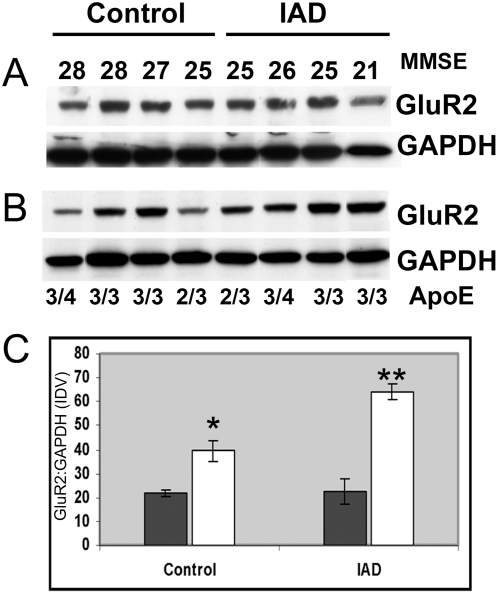
GluR2 protein expression.To determine if increased GluR2 mRNA generates elevated protein expression, we compared subjects with a range of MMSE values. Representative immunoblots of A) homogenates and B) synaptoneurosomes, (10 µg protein per lane) were detected with antibodies for GluR2 and GAPDH. C) In controls, the increased ratio (2-fold) of synaptoneurosome (white bar) GluR2 to total GluR2 in homogenates (* p<0.0002) is an indication of synaptic protein enrichment and this ratio increases by 50% in IAD patients (p<5.8E-08). In the IAD group there is a significant increase in synaptoneurosome GluR2 protein expression compared to control (** p<6.0E-05). Homogenate GluR2 (black bar) remains constant in controls and IAD. Data are mean values ±SEM for 4 controls and 4 IAD analyzed in 5 separate experiments. The ratio of GluR2 to GAPDH is given in arbitrary units based on the integrated density value which is the sum of all pixel values after background correction (IDV).